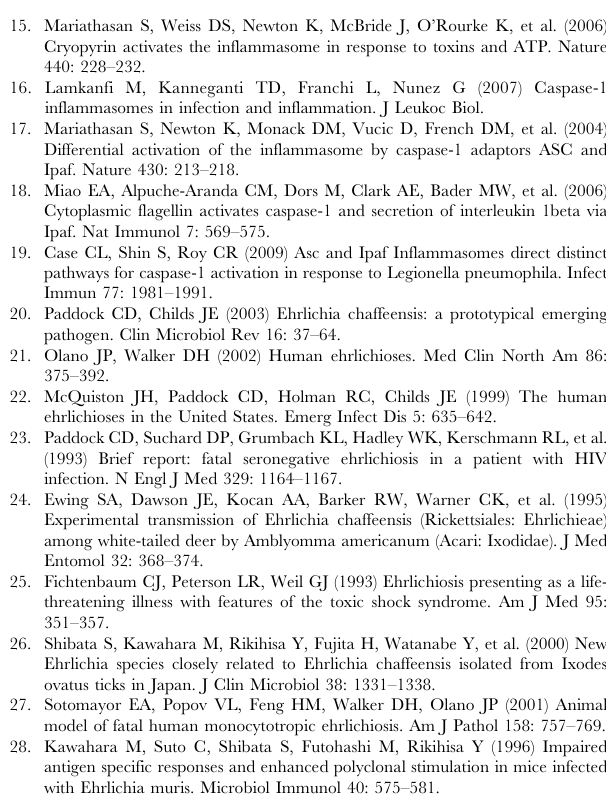
Figure S4 Rip2-independent E. muris recognition in DCs. Bone infected with E. muris for the indicated time period. (A) Cytokine production from infected cells was assessed by ELISA. LPS days post infection) were stained by Diff-Quick staining. Scale bar, qPCR using primers specific for the E. muris dsb gene. Data were normalized by qPCR data for the GAPDH gene in host genomic DNA. Error bars represent SD of triplicate samples. Data are representative of three independent experiments in A-C. Figure S5 IL-1 b production by Asc-, Nalp3-, or Ipaf-deficient macrophages infected with E. muris. Bone marrow-derived macrophages from both wild-type and Asc-, Nalp3- or Ipaf- deficient mice were treated with LPS (10 ng/ml) for 16 hours and then infected with E. muris in vitro for the indicated time period or stimulated with 2.5 mM ATP for 3 hours. IL-1 b secretion in the culture supernatants was assessed by ELISA. Error bars represent SD of triplicate samples. Data are representative of three independent experiments. Figure S6 MyD88-dependent E. muris recognition in macro- phages. Bone marrow-derived macrophages from wild-type and MyD88-deficient mice were infected with E. muris in vitro for the indicated time period. (A) Cytokine production from infected cells was assessed by ELISA. LPS (10 ng/ml) stimulation was used as